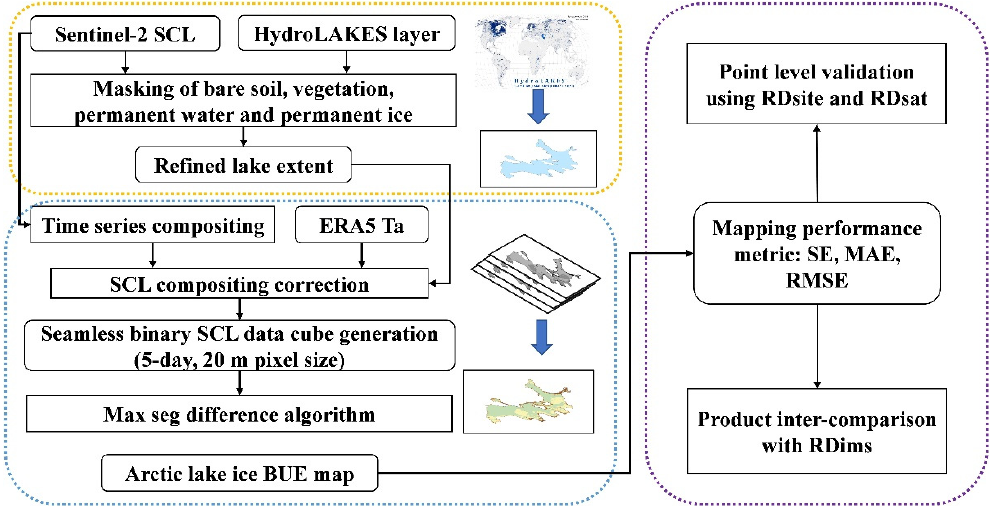
Figure 2. Flow chart of the lake ice BUE mapping proposed in this